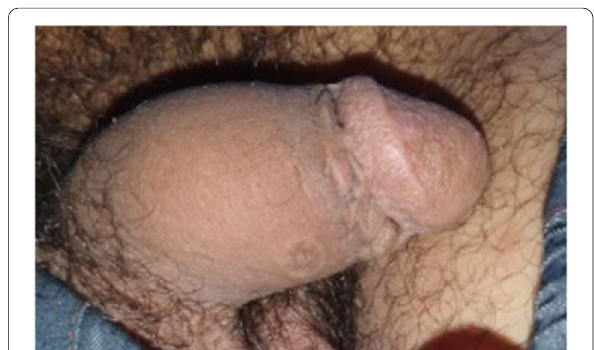
Fig. 2 Scar of chancre and achromatic spots on penis